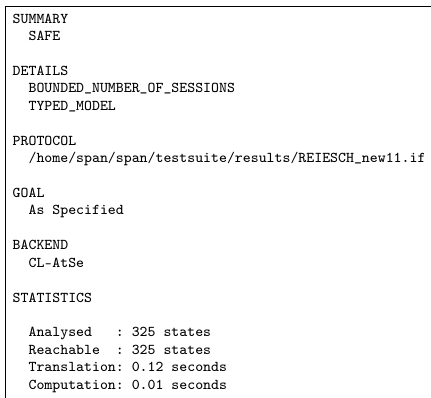
Figure 15. Simulation result using OFMC.